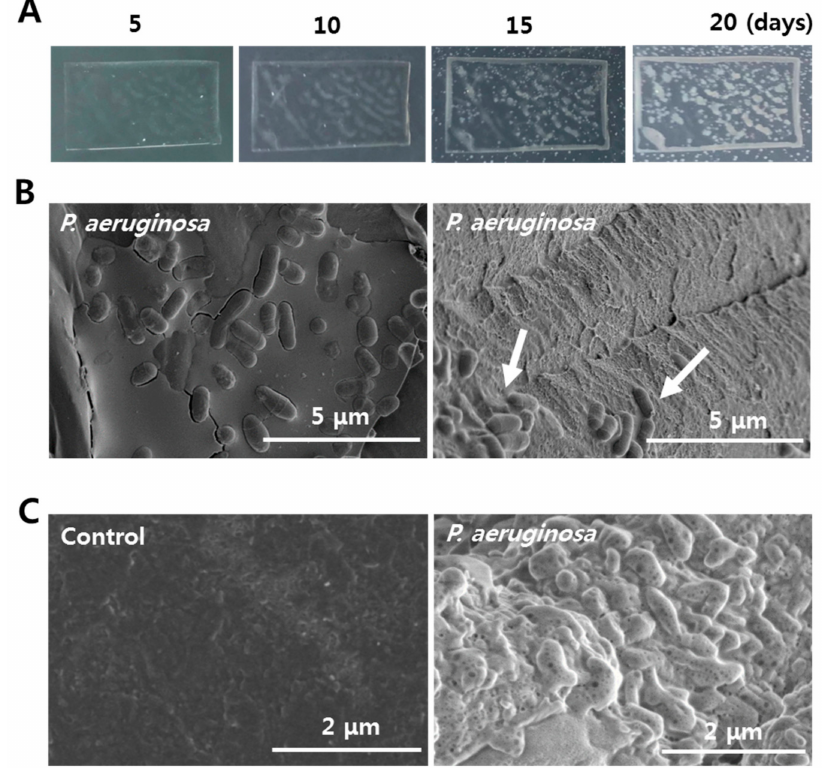
Figure 1. Isolation of polystyrene (PS)-degrading P. aeruginosa from the gut extract of PS-ingesting superworms. ( A ) Growth of P. aeruginosa on PS films during a 20-day period. White color on the middle and sides of the PS film shows growth of P. aeruginosa. ( B ) Biodegradation of PS beads by P. aeruginosa . Before (left) and after SDS treatment (right) are shown. The remaining P. aeruginosa were still attached onto the surfaces of PS beads (indicated by white arrow). ( C ) Surface changes on PS beads during biodegradation by P. aeruginosa (right). PS beads without bacteria were used as controls